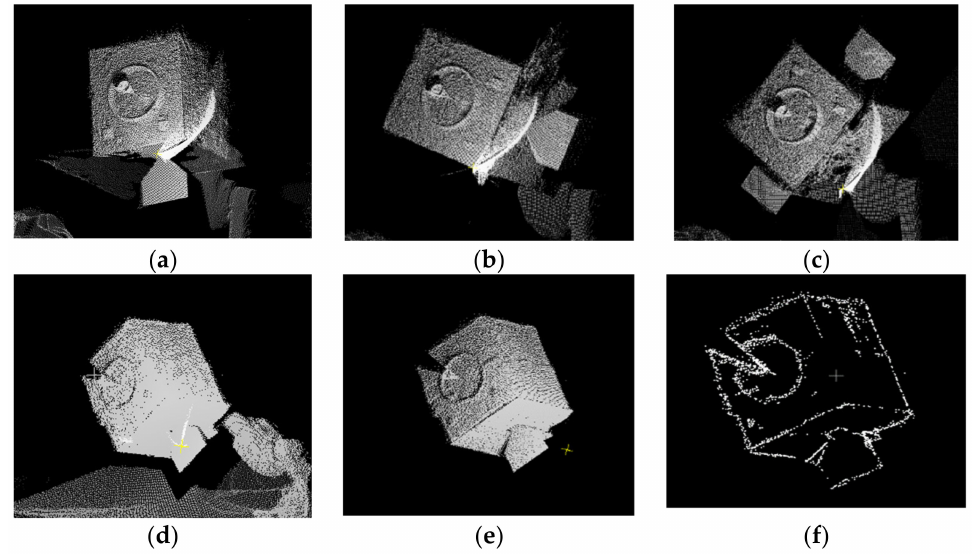
Figure 8. Input data processing. ( a ) Frame i; ( b ) Frame j; ( c ) Frame k; ( d ) Raw data; ( e ) Noise reduction; ( f ) Salient point